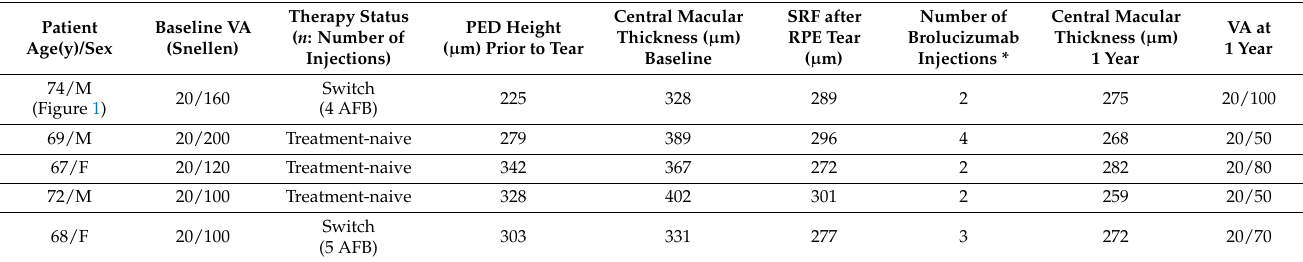
Table 1. Important characteristics of patients with pigment epithelial tears who received brolucizumab.